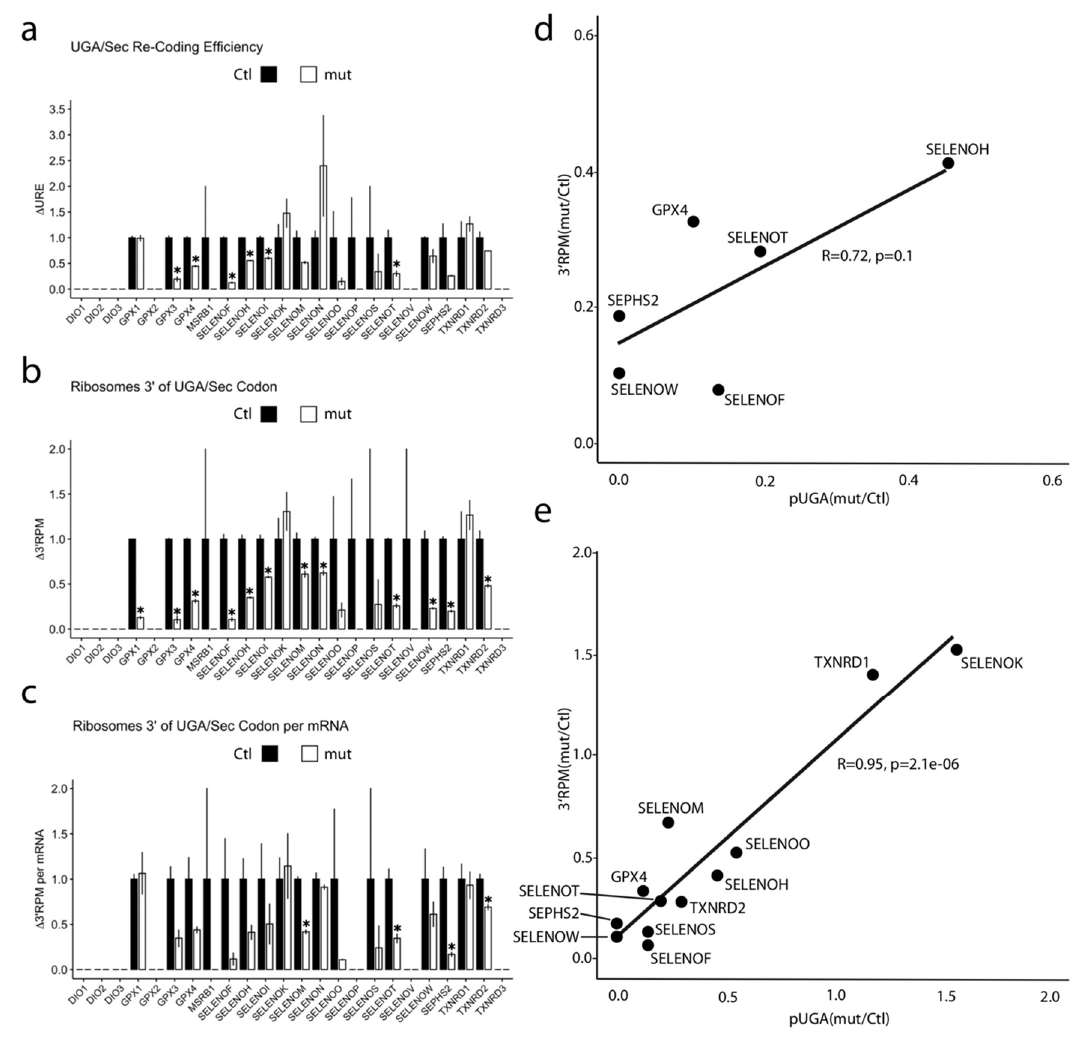
Figure 4. UGA recoding events probed by ribosomal profiling. ( a ) UGA recoding efficiency